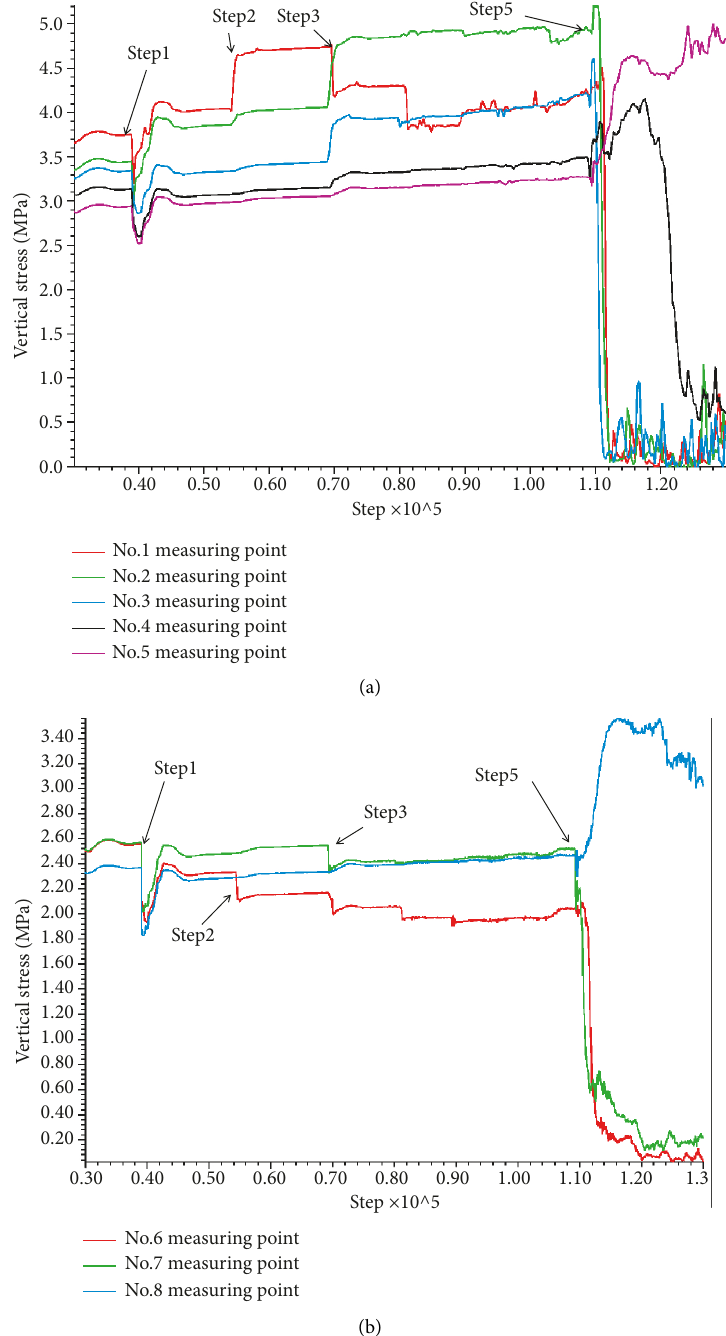
Figure 18: Vertical stress of rock mass during mining. (a) Vertical stress of the pillar during mining. (b) Vertical stress of roof filling body during